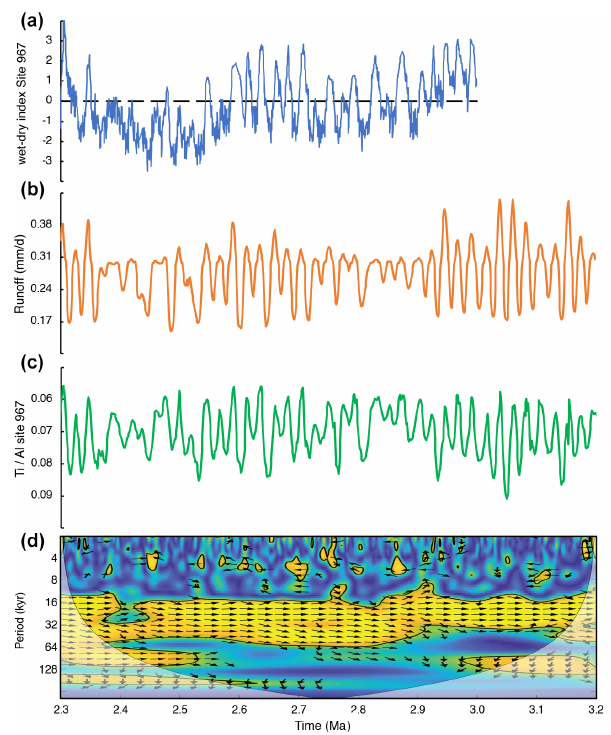
Figure 11. Records of African climate and Mediterranean sedi- ments. (a) The wet–dry index as calculated by Grant et al. (2017) from Site 967, indicating wet and dry phases in northwest and east- ern Africa. (b) The optimal runoff combined record of 35% runoff 11 plus 65% runoff 12 from CLIMBER-2. (c) The Ti / Al record from Site 967, with the y axis reversed, and (d) a wavelet coher- ence diagram (Grinsted et al., 2004) of runoff with Ti / Al. The colour scale indicates coherence, with > 95% confidence levels in- dicated by the black lines (orange to yellow colours). The arrows in- dicate the phase, with right-pointing meaning in phase and upward- pointing mean a lead of runoff relative to Ti /